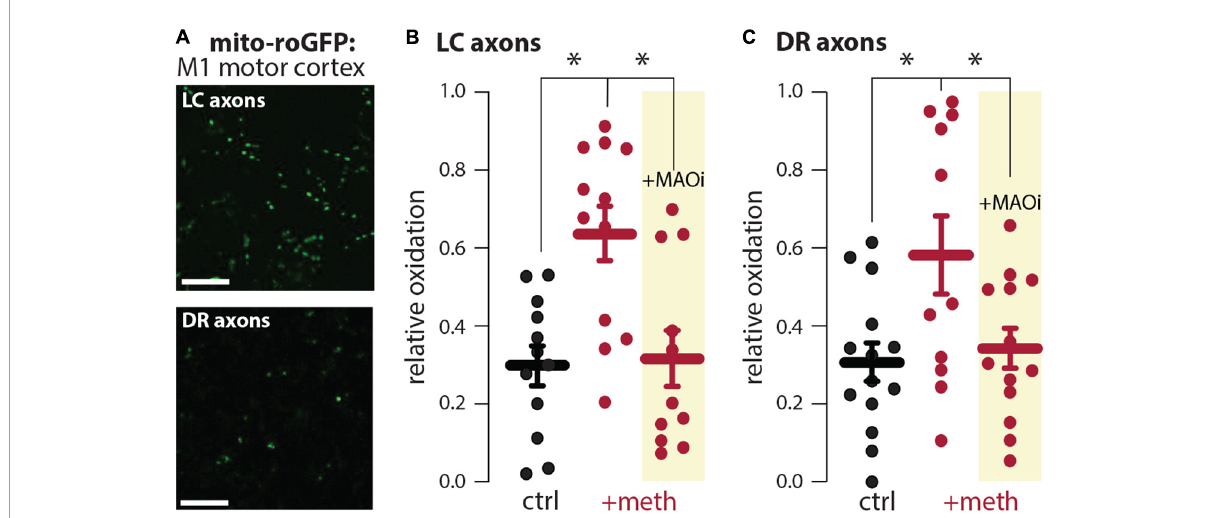
FIGURE1 Meth increased monoamine oxidase (MAO)-dependent mitochondrial oxidant stress in locus coeruleus (LC) and dorsal raphe (DR) axons. (A) Sample image (top) in the primary motor cortex showing expression of the redox biosensor roGFP targeted to the mitochondrial matrix (mito-roGFP) in LC axons; scale bar denotes 10 µ m. Sample image (bottom) in the primary motor cortex showing the redox biosensor mito-roGFP expressed in DR axons; scale bar denotes 10 µ m. (B) Compared to aCSF perfusion (ctrl), meth (+meth, 10 µ M) increased LC axonal mitochondrial oxidant stress which was attenuated by the MAO inhibitor rasagiline (+MAOi, 1 µ M; ctrl n = 12 brain slices/4 mice, +meth n = 12 brain slices/4 mice, +MAOi n = 11 brain slices/4 mice). Data analyzed using Kruskal-Wallis [ H ( 2 ) = 11.60, p = 0.0030] with Dunn’s post-hoc (ctrl vs. +meth, p = 0.0090; ctrl vs. +MAOi, p > 0.9999; +meth vs. +MAOi, p = 0.0109). (C) +meth similarly increased mitochondrial oxidant stress in DR axons in the primary motor cortex and +MAOi attenuated the increased mitochondrial oxidant stress; ctrl n = 14 brain slices/5 mice, +meth